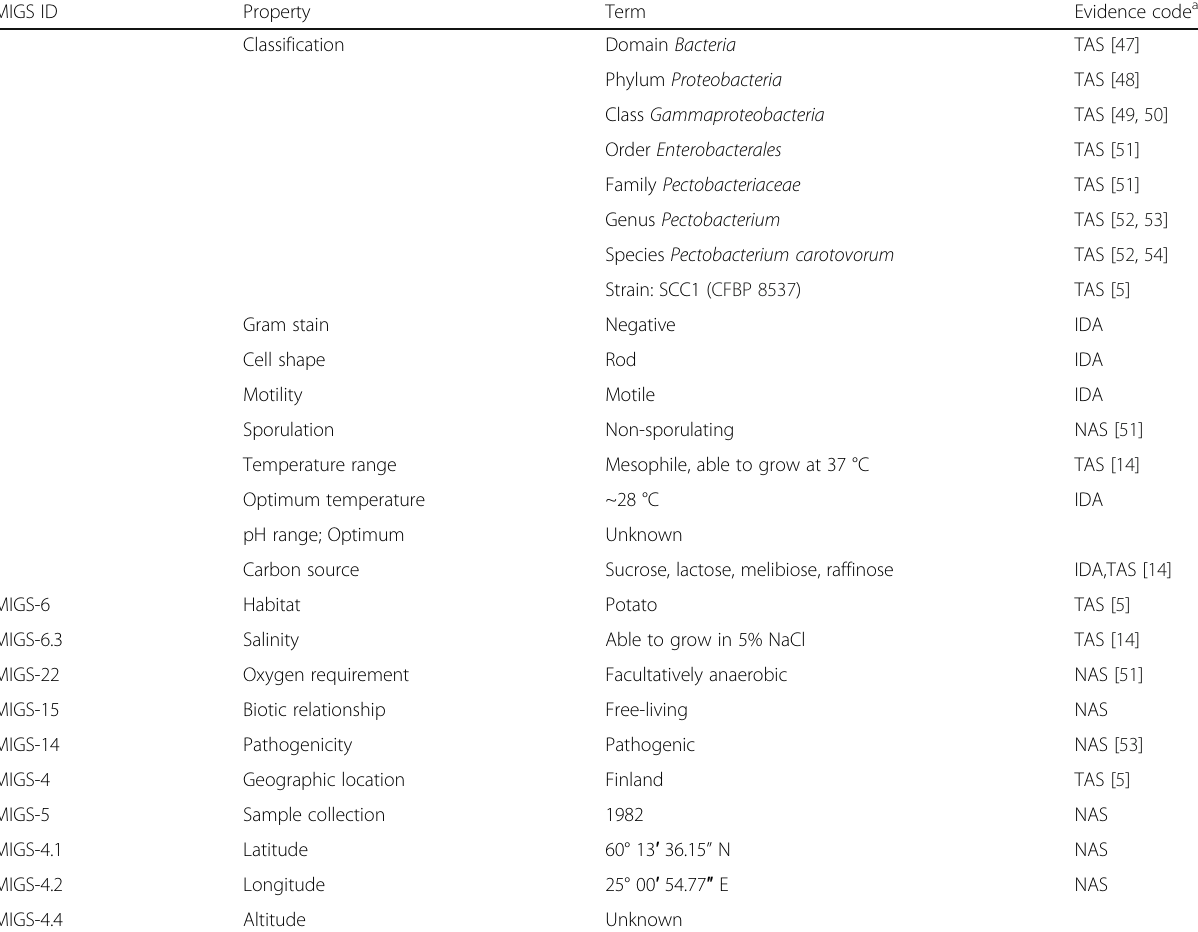
Table 1 Classification and general features of Pectobacterium carotovorum strain SCC1 [46]